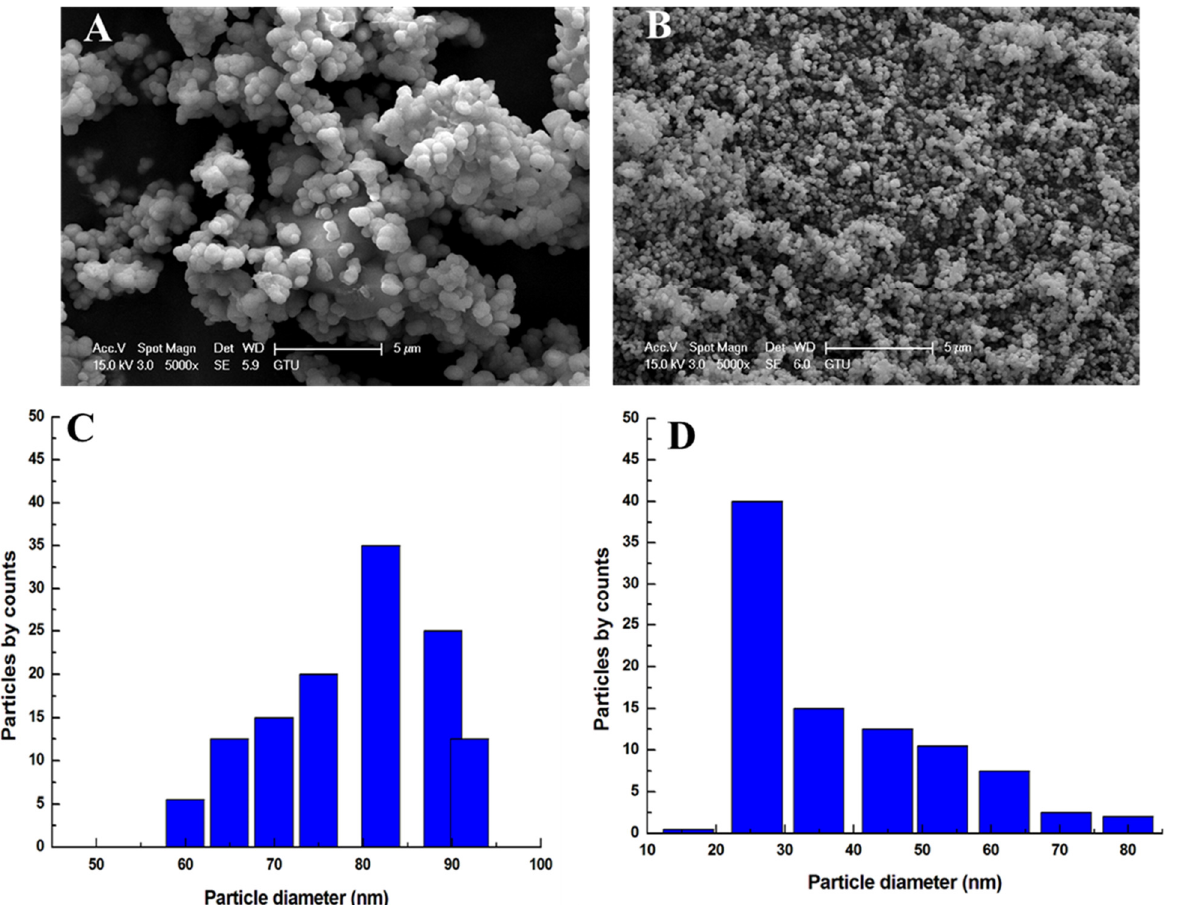
Figure 4. Scanning electron microscope (SEM) image of TiO 2 nanoparticles (( A ) for TiO 2 NPs at 1 h, and ( B ) for TiO 2 NPs at 5 h) at ×5000 magnification and histogram of particle size distribution curve of TiO 2 NPs (( C ) for NPs at 1 h and ( D ) for NPs at 5 h).